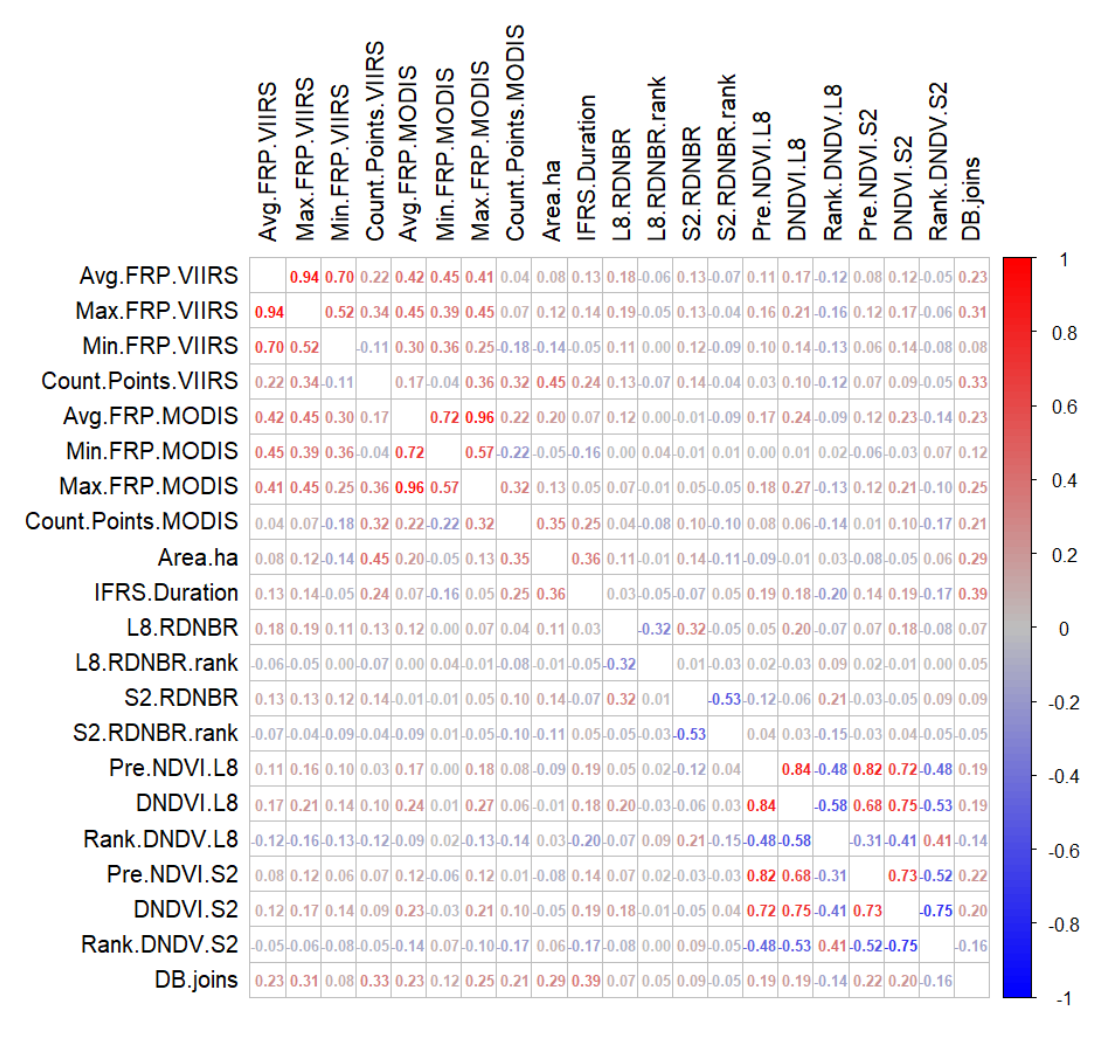
Figure 9. Spearman’s rank correlation coefficients between the quantitative variables of the wildfires in the unified database (n = 2276) (area > 10 ha).